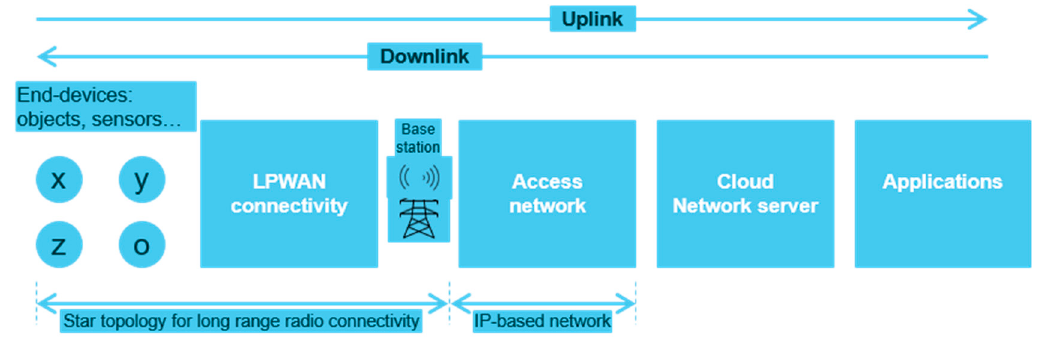
Figure 4. Typical topology of IoT devices deployment using Sigfox .